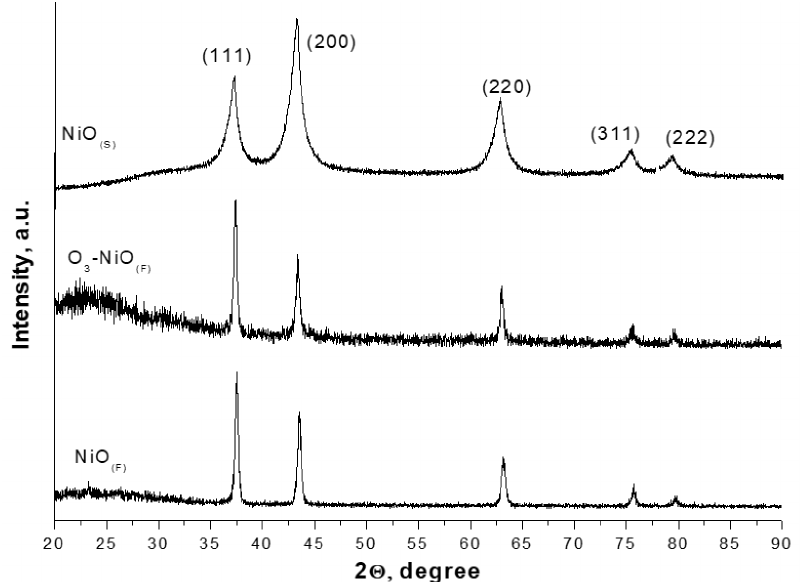
Figure 2. X-ray diffraction XRD patterns of NiO ( S ) , O 3 - NiO ( F ) and NiO ( F )